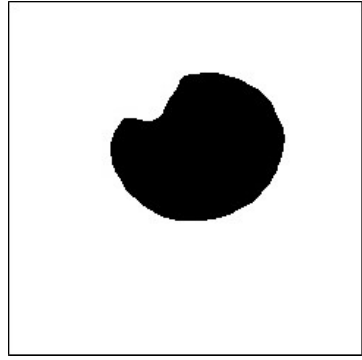
Figure 34. Pupil image use multithresholds.